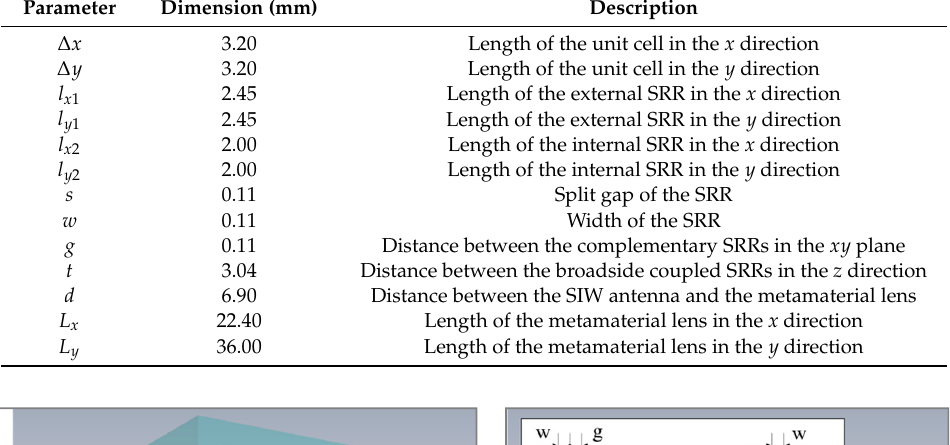
Table 2. List of the geometric parameters of the SRR Unit Cell of Figures 2, 4 and 5.